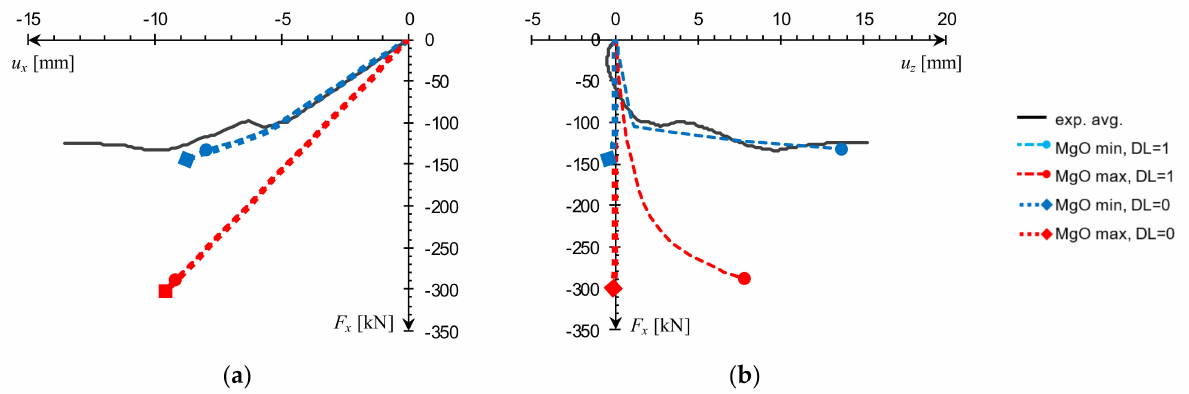
Figure 12. Dead load influence on e0 panel FEA results: ( a ) F x ( u x ), ( b ) F x ( u z ) at